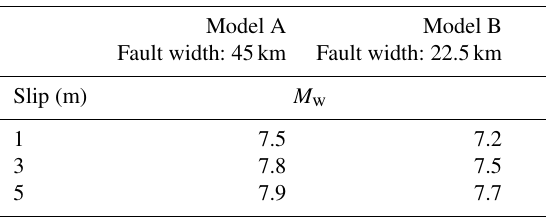
Figure 4. Influence of tapering the updip slip on seafloor deforma- tion. The maximum slip varies across the models in order to pre- serve the mean slip. (a) The seafloor deformation profiles have sim- ilar amplitudes and shapes with slightly offset peaks, even for very significant tapers. (b) Different slip tapers considered. A more grad- ual taper (red shades) shifts the peak uplift in the downdip direction of the fault ramp. A more abrupt slip taper (blue shades) shifts the peak uplift towards the upper fault bend. Table 2. Equivalent moment magnitudes ( M w ) for models A and B for a given slip amount. Model A ruptures the full ramp, while model B ruptures only the upper half of the ramp. Both models have a fault length of 116km. The magnitudes here are minima as each of these events could also include slip on the along-strike part of the